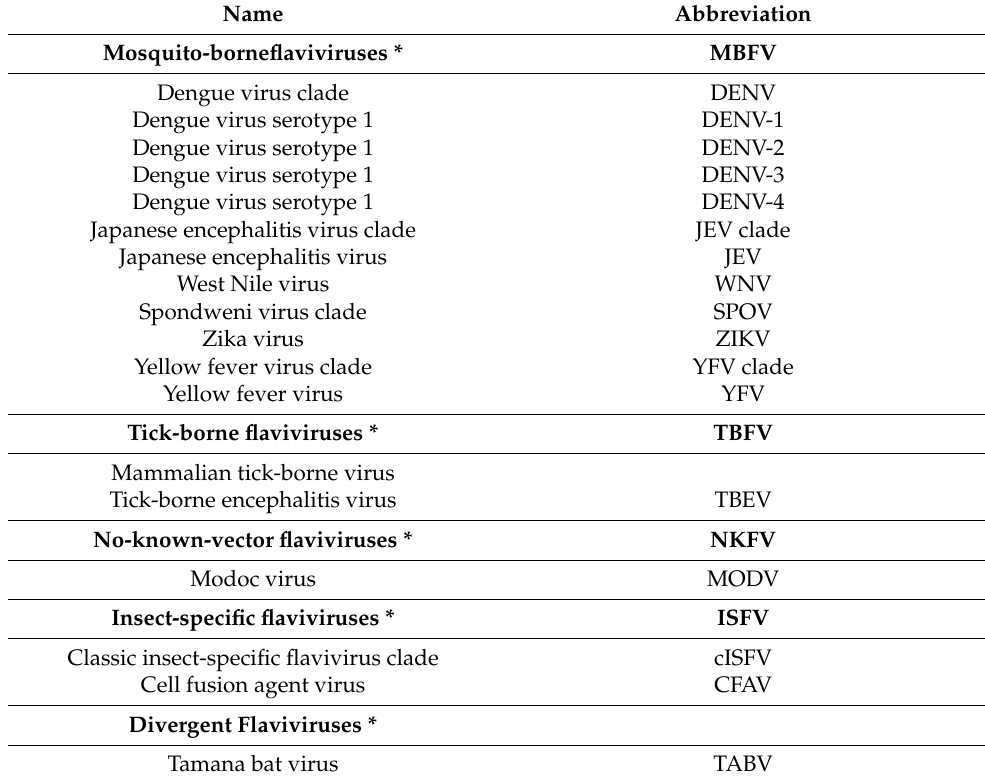
Table 1. Classification of